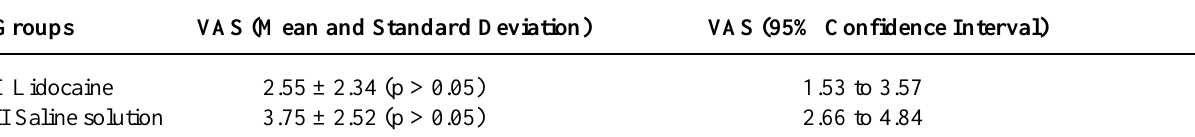
Table 2 – Mean, standard deviation and 95% confidence interval for pain score by visual analogical scale (VAS) in groups I and